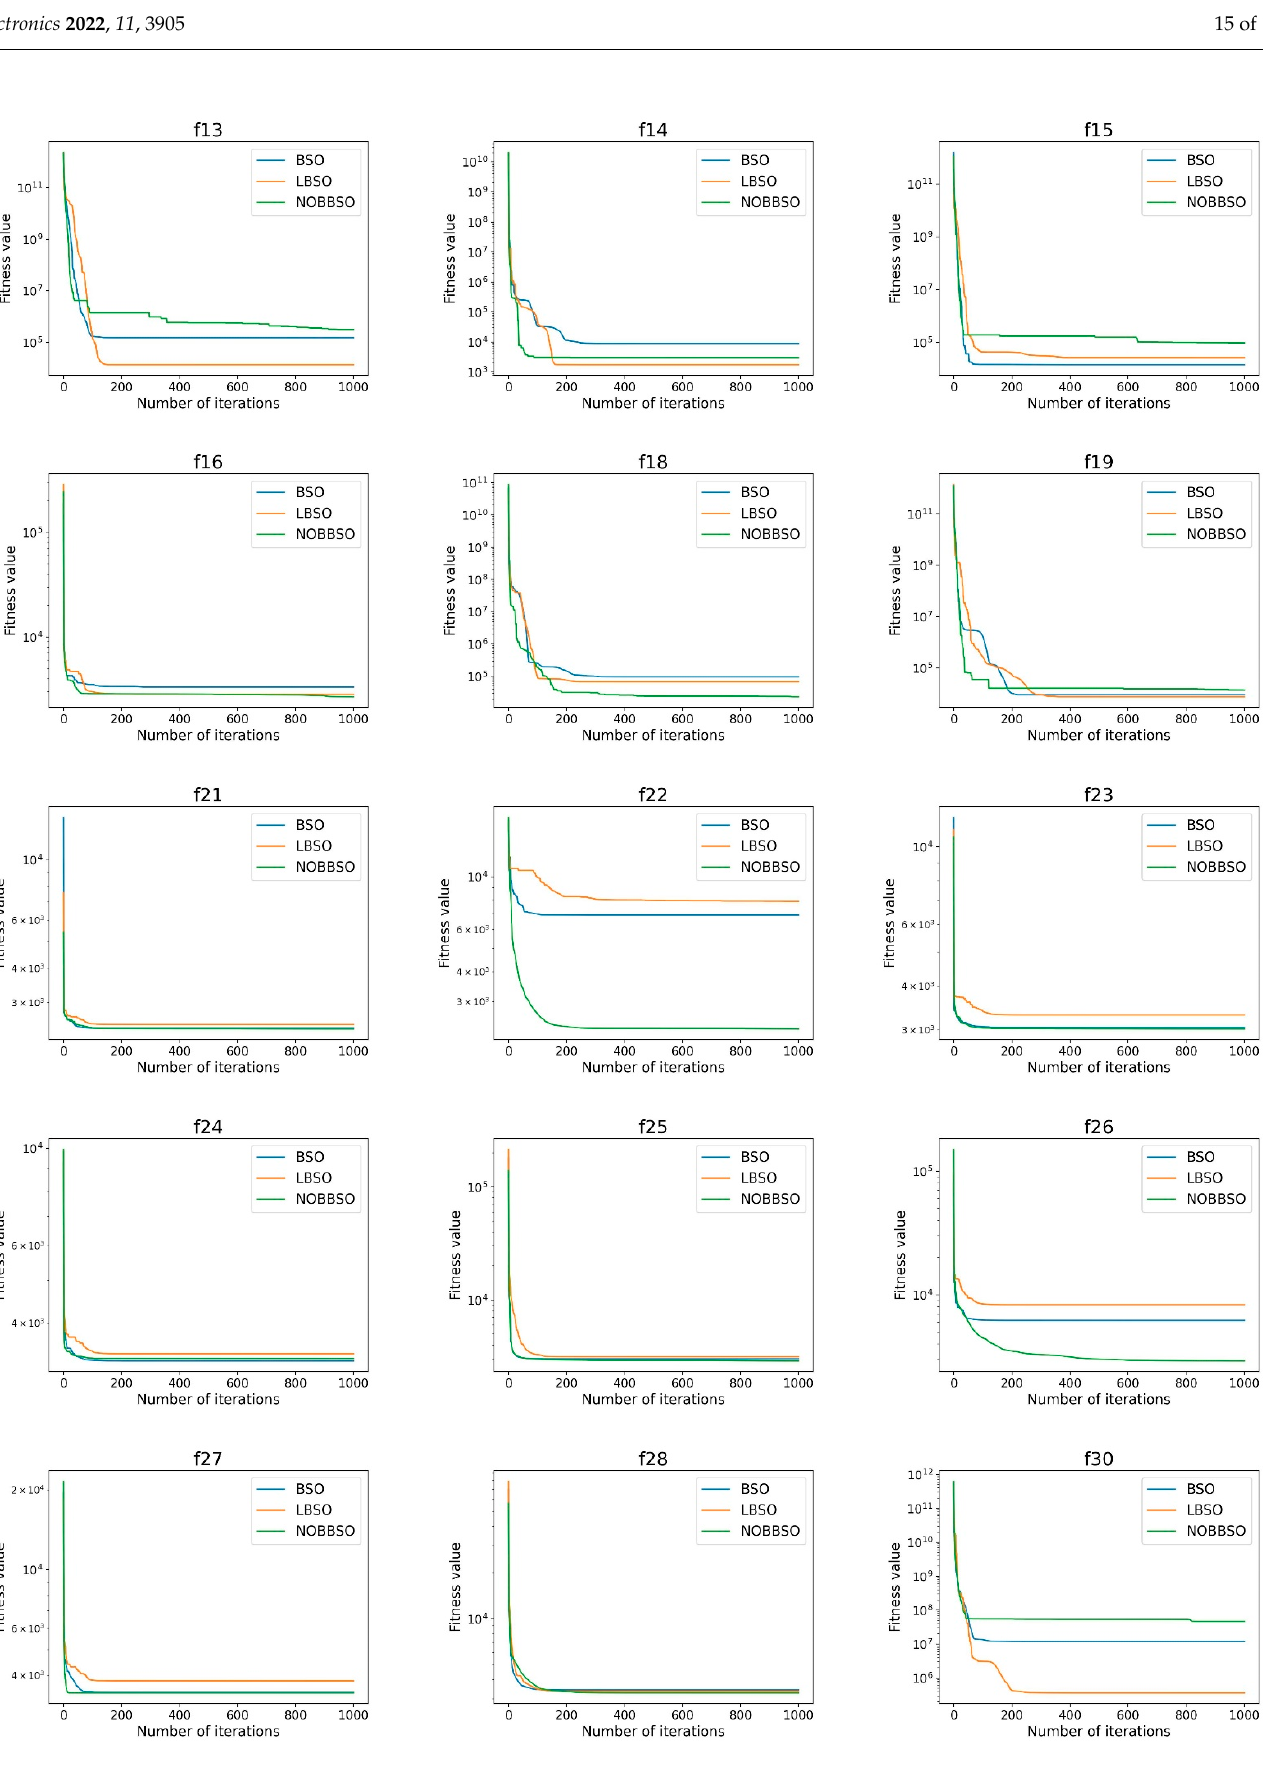
Figure 3. The analysis diagram of convergence.